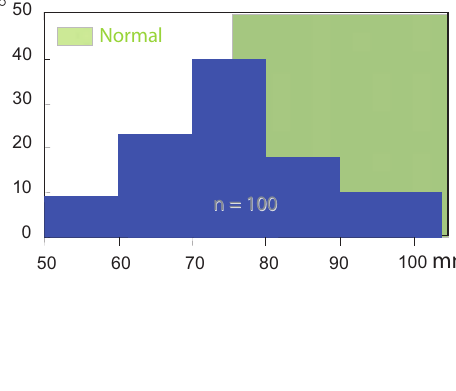
Figure 2 Distribution of arte- rial PCO 2 values in 100 consecutive patients with liver cirrhosis. Shaded area: limits of normal. From